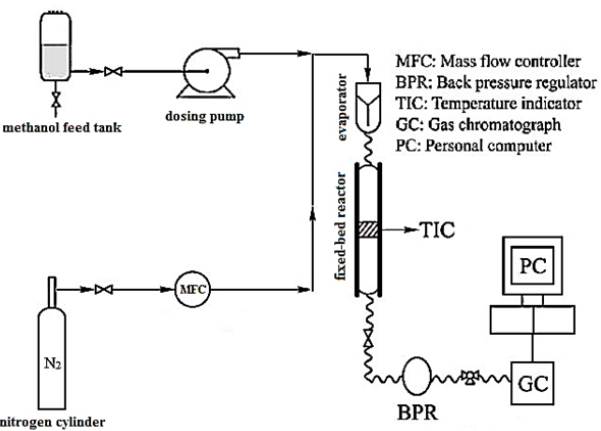
Fig. 1. Schematic view of experimental setup.